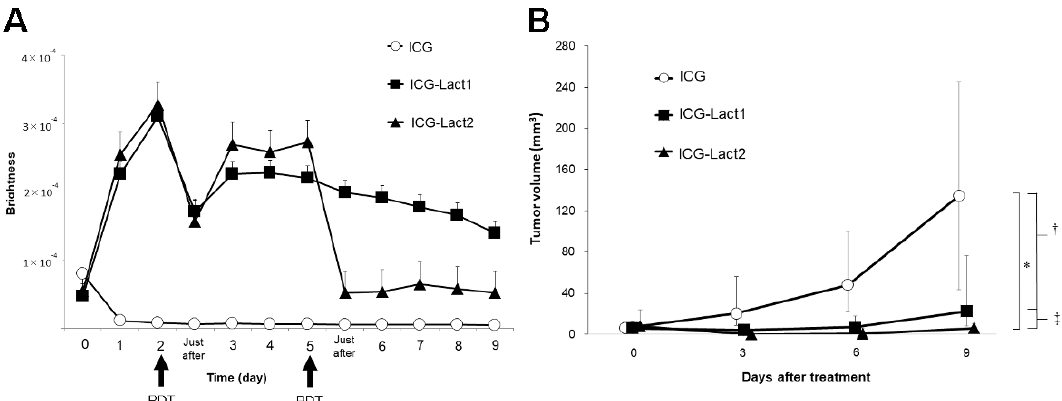
Figure 7. Photodynamic diagnosis of lymph node metastasis. ( A ) In vivo images of the popliteal lymph nodes ( arrowheads ). ( B ) Ex vivo images of the bilateral popliteal lymph nodes. (Reprinted from Tsujimoto et al. [22] with permission from Springer Nature).